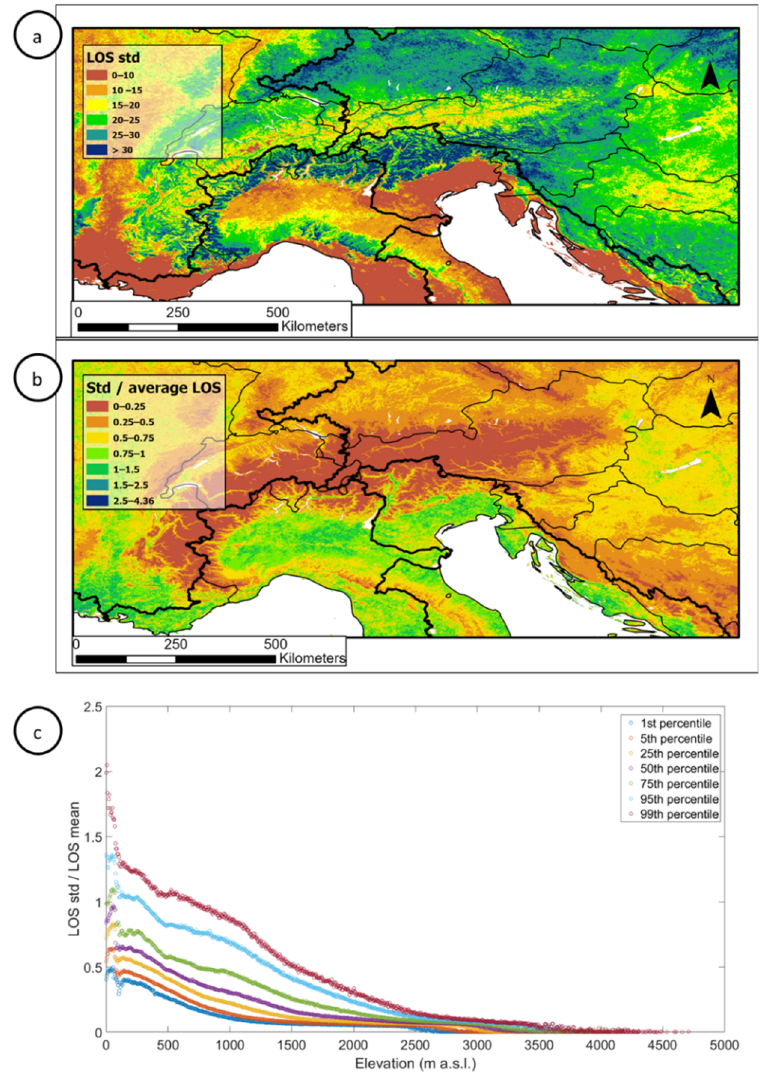
Figure 5. ( a ) Standard deviations of the snow cover season length (LOS) in the 2000–2019 period expressed in days; ( b ) ratio between the LOS standard deviations and LOS mean values; ( c ) quantiles of the distribution of the ratios between the LOS standard deviations and LOS mean values in each 5-m interval of the GAR elevation range.